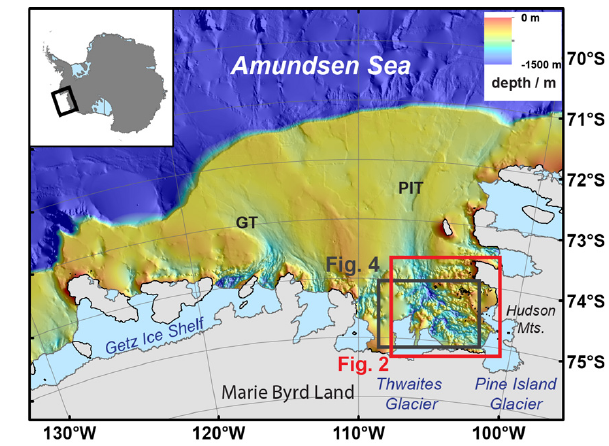
Fig. 1. Bathymetry map of the Amundsen Sea shelf with the red rectangle marking the location of the Pine Island Bay study area in Figs. 2 and 4 (based on Nitsche et al., 2007). PIT marks the Pine Island Trough system and GT the Dotson-Getz Trough